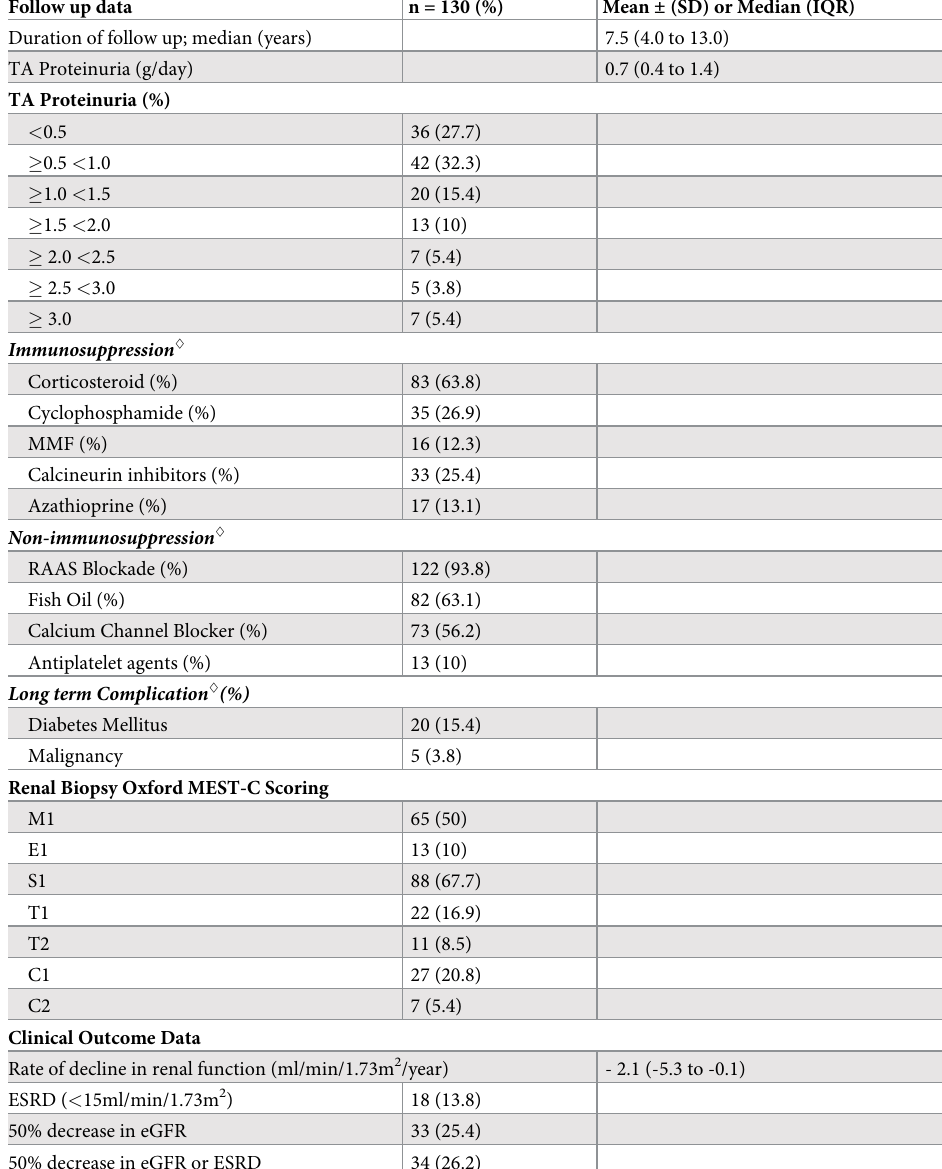
Table 2. Follow-up data and clinical outcomes of patients with IgA nephropathy. Follow up data n = 130 (%) Mean ± (SD) or Median (IQR) Duration of follow up; median